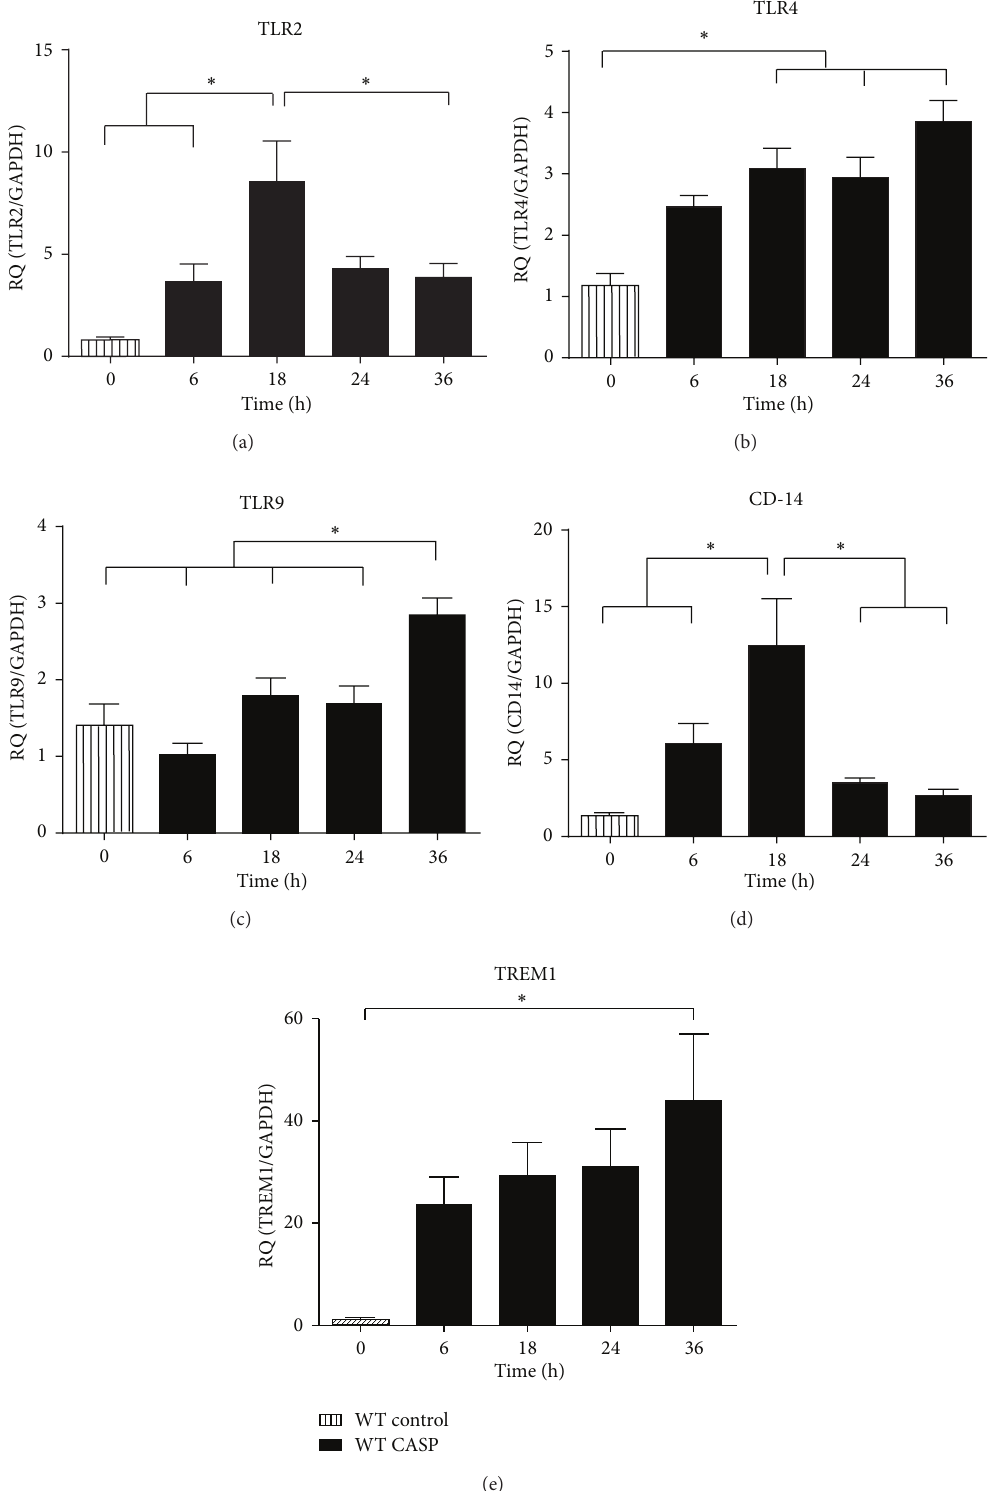
Figure 3: Immune receptor profile in WT hearts. (a)–(e) Messenger RNA levels of TLR2, 4, and 9, CD-14 (a)–(d), and TREM1 (e) were analysed 6, 18, 24, and 36 h after sepsis induction. Untreated WT mice served as control (a)–(e) ( ∗ : 𝑃 < 0.05 ; 𝑛 = 10/ group; mean ±